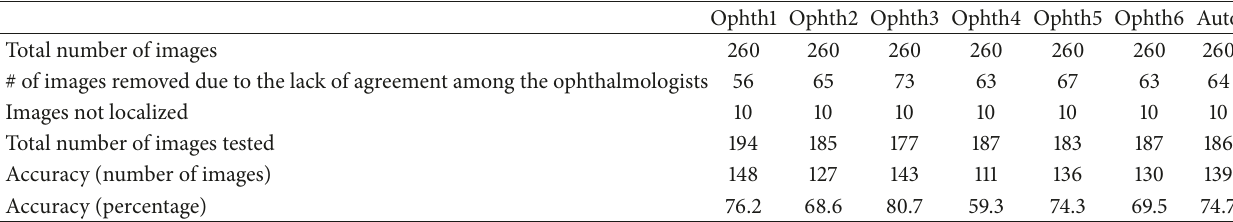
Table 4: The HCDR results for MESSIDOR images set.